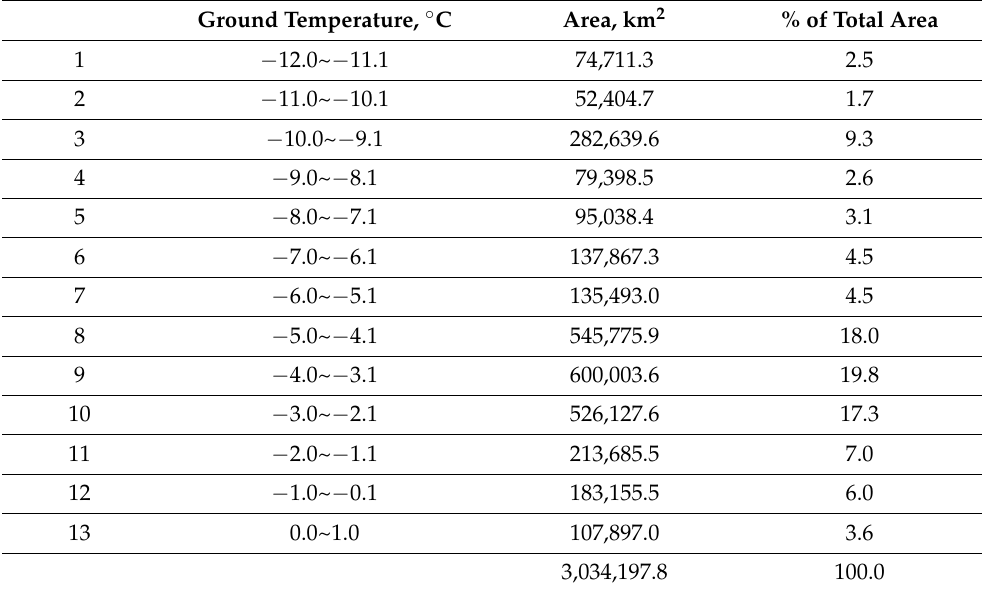
Table 1. Spatial distribution of ground